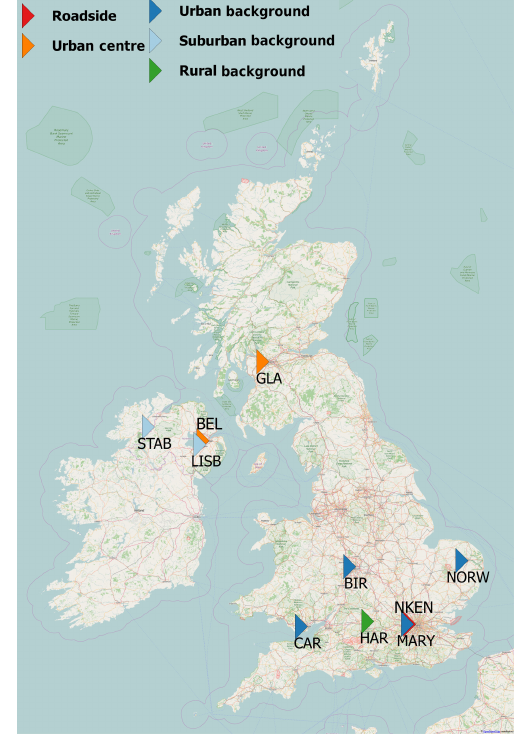
Figure 12. BC-network measurement site locations in 2012.